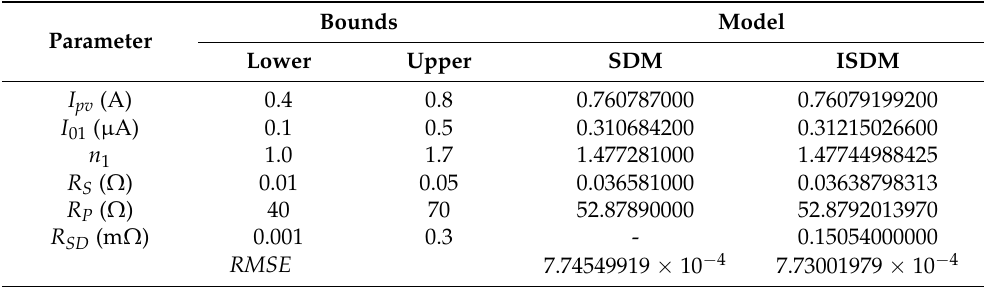
Table 1. Lower and upper bounds of the parameters and the results obtained for the RTC France solar cell for both SDM and